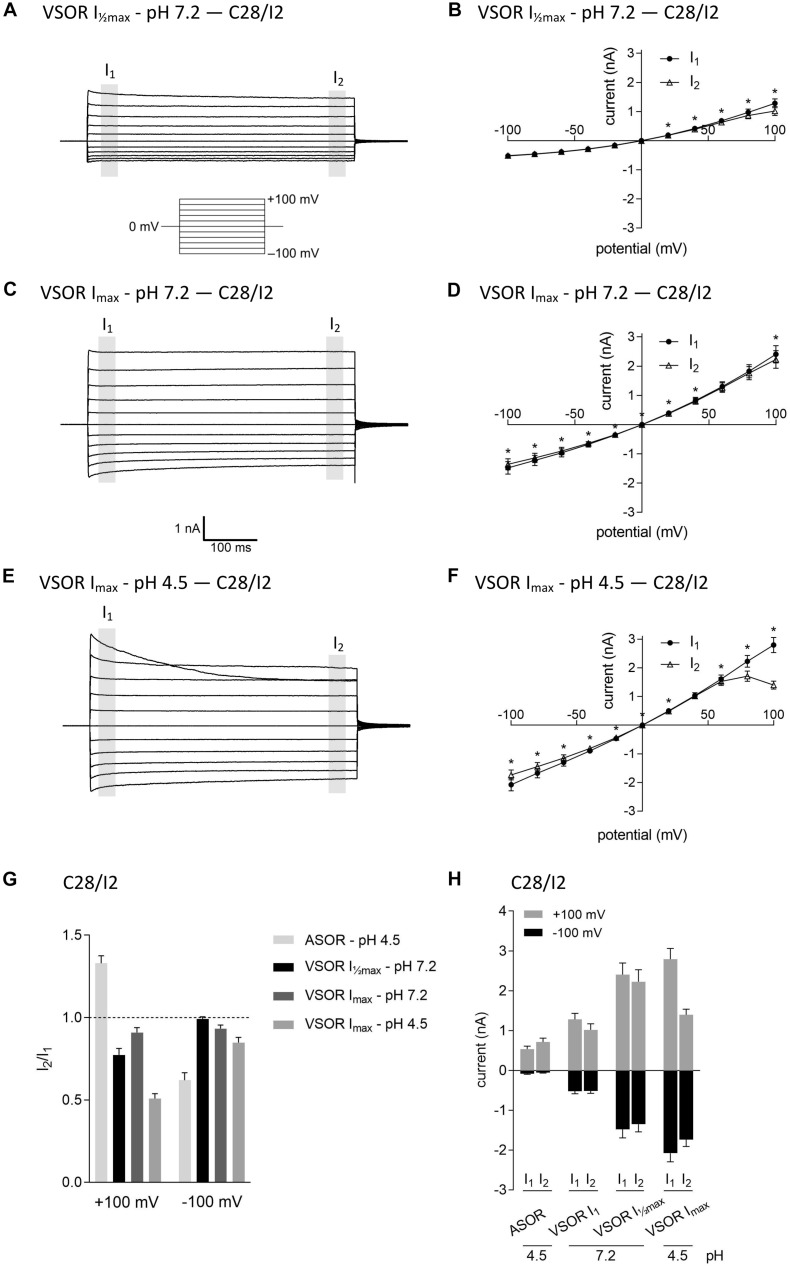
The volume-sensitive outwardly rectifying (VSOR) current in C28/I2 cells is affected by low pH. Examples of VSOR current traces elicited by 500-ms voltage steps from –100 to +100 mV obtained at half-maximal VSOR current amplitudes (VSOR Imax—pH 7.2) (A), at maximal VSOR current amplitudes (VSOR Imax—pH 7.2) (C), and at maximal VSOR current amplitudes immediately after reducing pHe to 4.5 (VSOR Imax—pH 4.5) (E). (B,D,F)
I–V relationships of mean VSOR currents analyzed at the beginning (I1—closed circles) and at the end (I2—open triangles) of voltage pulses (indicated by gray shadings in A, C, and E). (B) VSOR Imax—pH 7.2 (n = 10). (D) VSOR Imax—pH 7.2 (n = 11). (F) VSOR Imax—pH 4.5 (n = 9). Asterisks indicate significant differences between I1 and I2 (p < 0.05). Paired t-tests. (G,H)
I2/I1 ratios and mean current amplitudes, respectively, of ASOR currents and VSOR Imax—pH 7.2, VSOR Imax—pH 7.2, and VSOR Imax—pH 4.5 currents at +100 and –100 mV. Means ± SEM (n = 9–11). I2/I1 ratio > 1, time-dependent activation; I2/I1 ratio < 1, time-dependent inactivation.